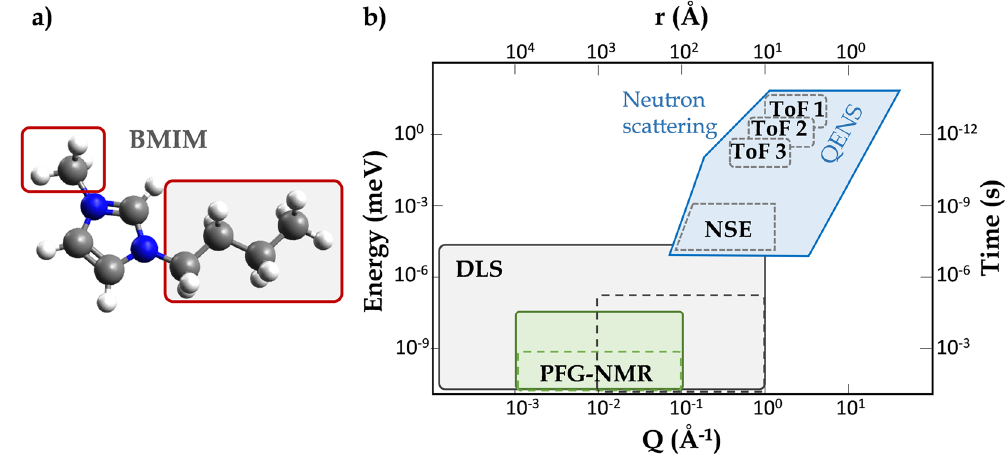
Figure 1. ( a ) This study focuses on the multi-scale dynamics of the cation of BMIM-TFSI. On the chemical structure above the red squares identify the methyl and alkyl side-chains carried by the imidazolium ring. While the quantity of interest here is the long-range translational diffusion coefficient of the center-of-mass of the whole cation, the QENS/NSE signal is very sensitive to the dynamics of the side-chains. The neutron experiments have been carried out on the fully protonated cation, but in order to challenge the robustness of the model we propose, the neutron contribution of the alkyl side-chain (squares filled in grey color) has been hidden by deuteration. Throughout this paper, this selectively deuterated cation sample will be called B(d9) MIM-TFSI. (b) Space and time plot illustrating the scales probed by Time-of-Flight (ToF) Quasi-Elastic Neutron Scattering (QENS), Neutron Spin-Echo (NSE), Pulsed-Field Gradient Nuclear Magnetic Resonance (PFG-NMR) and Dynamic Light Scattering (DLS). The shaded lines indicate the generic space and time scales accessible with these techniques. The scales specifically accessed in the present paper are shown with dotted rectangles. The three regions in time and space covered by the three instrumental conditions used in QENS here are labeled as ToF1, ToF2 and